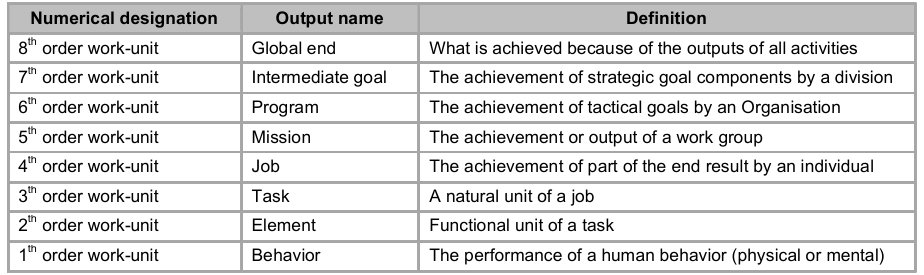
Orders of work units (Jackson,